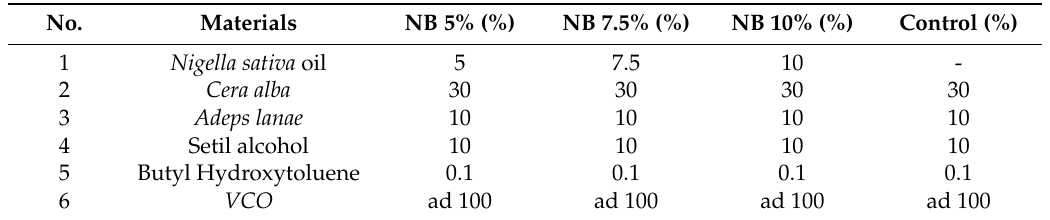
Table 1. Nigella sativa balm stick formula.